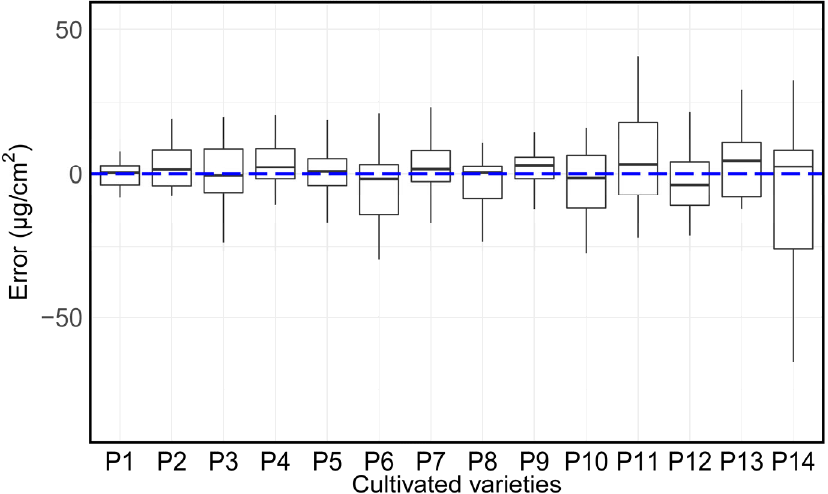
Figure 11. Error results of CCD under different species based on the RF and IV datasets. The P1, P2, P3, P4, P5, P6, P7, P8, P9, P10, P11, P12, P13, and P14 represent the 14 varieties, respectively.